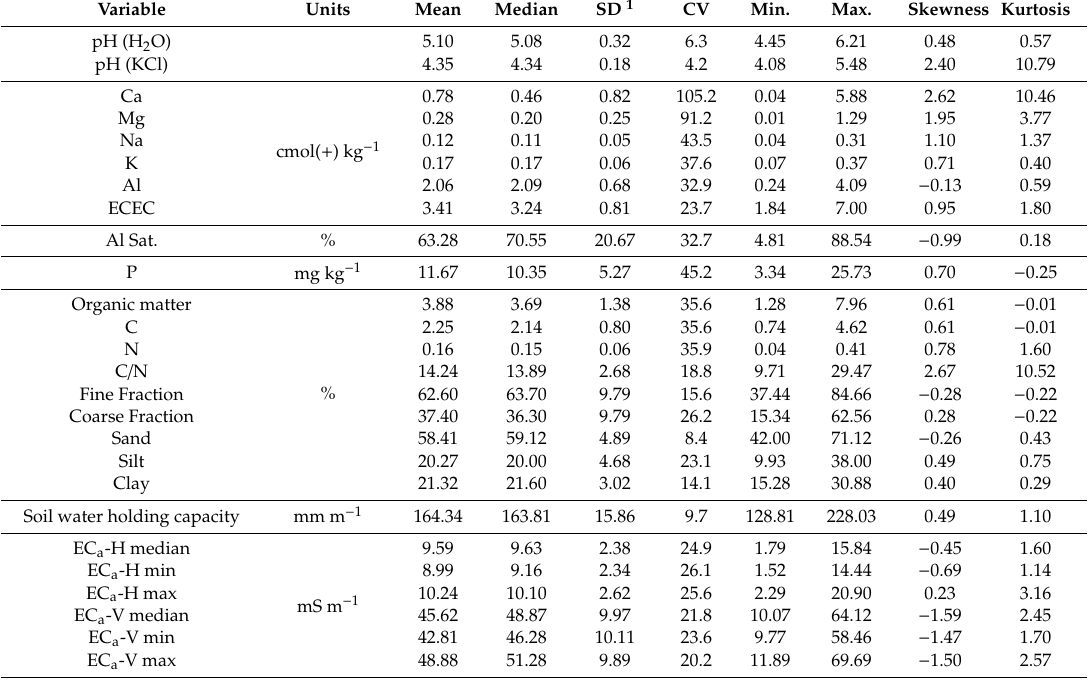
Table 1. Statistical summary of the soil properties studied in the experimental